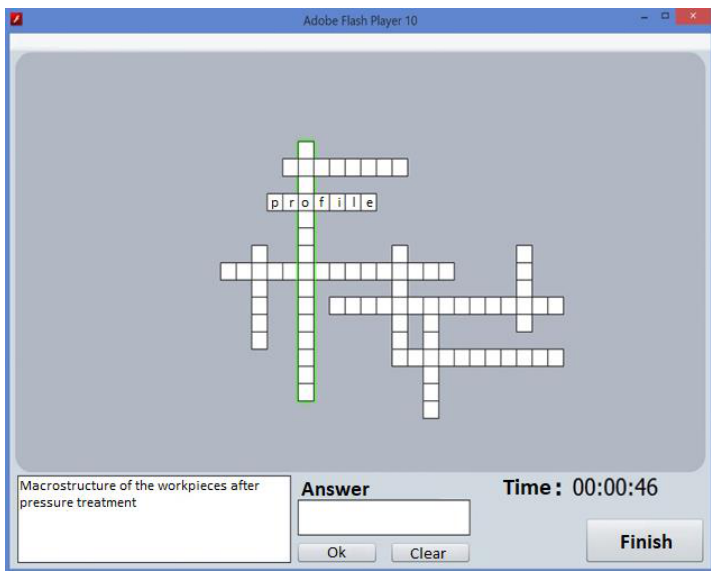
Fig. 2. Crossword